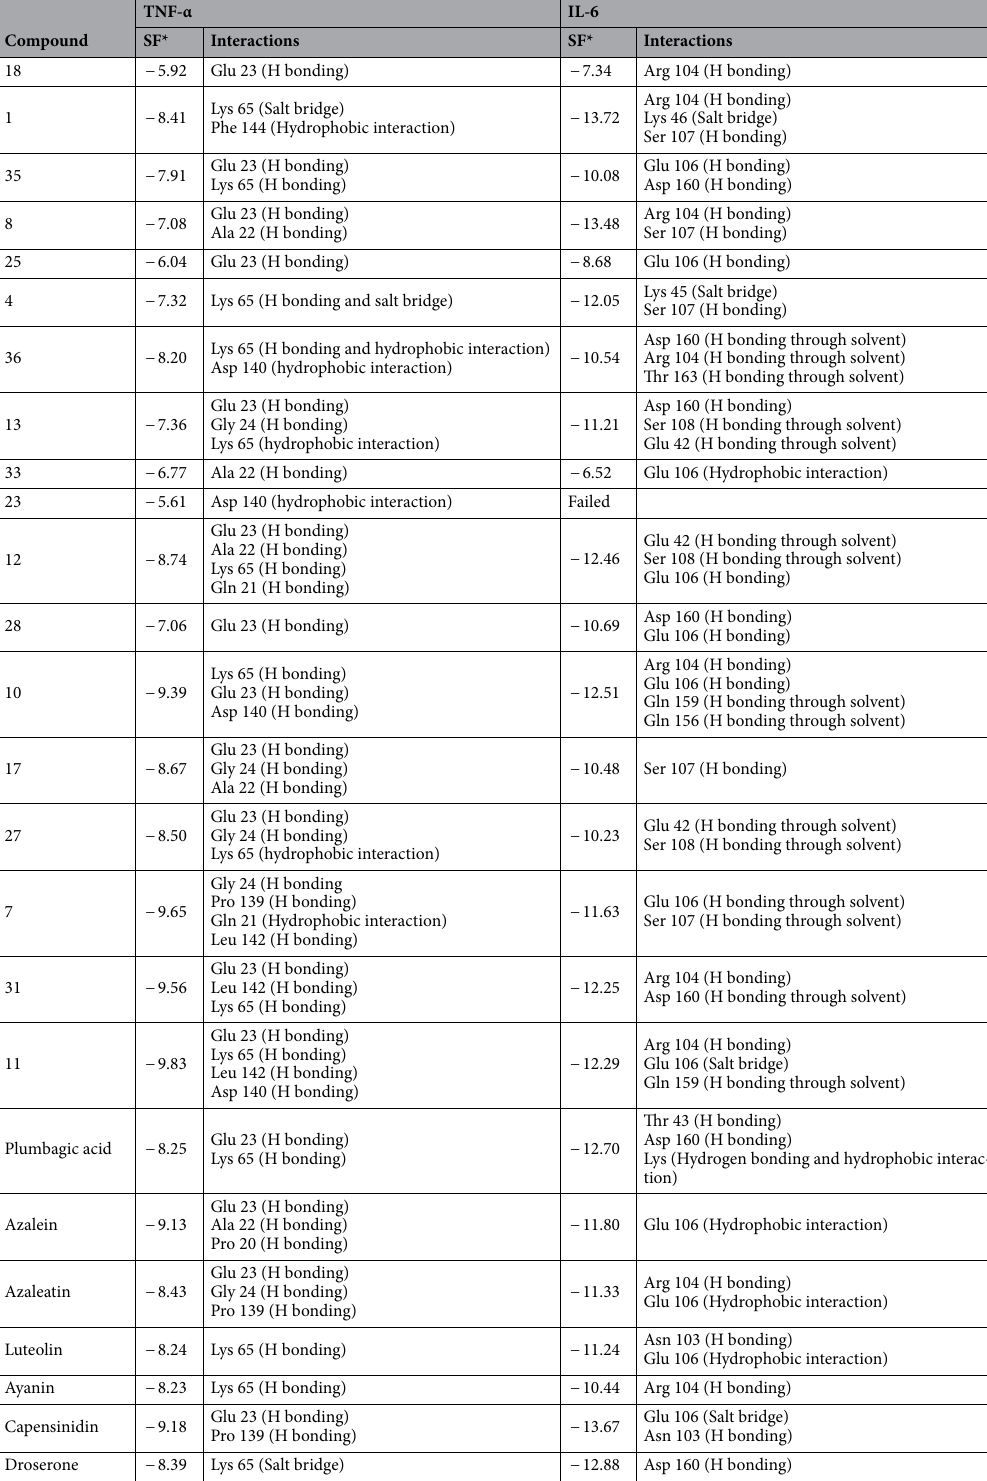
Table 3. Score functions and interactions of P. indica and P. auriculata secondary metabolites in TNF-α and IL-6 active sites using in silico modeling. Compound numbers are from Table 1. *Score function